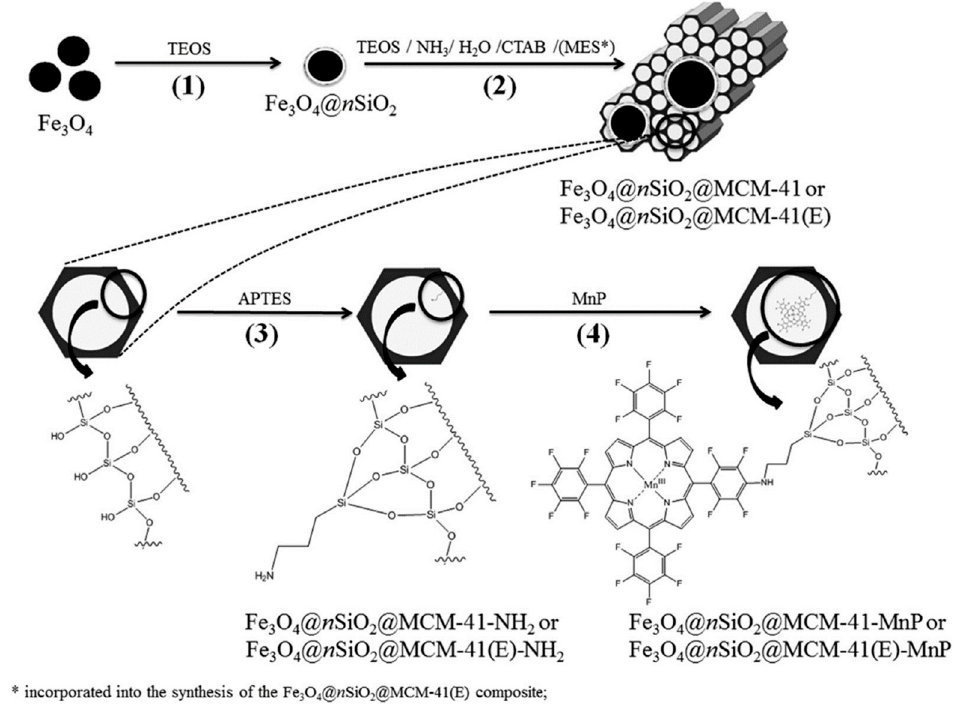
Figure 56. Synthetic route for the preparation of Fe 3 O 4 @nSiO 2 @MCM-41-MnP and Fe 3 O 4 @nSiO 2 @MCM-41(E)-MnP catalysts. Reproduced with permission from [149]. Copyright 2016